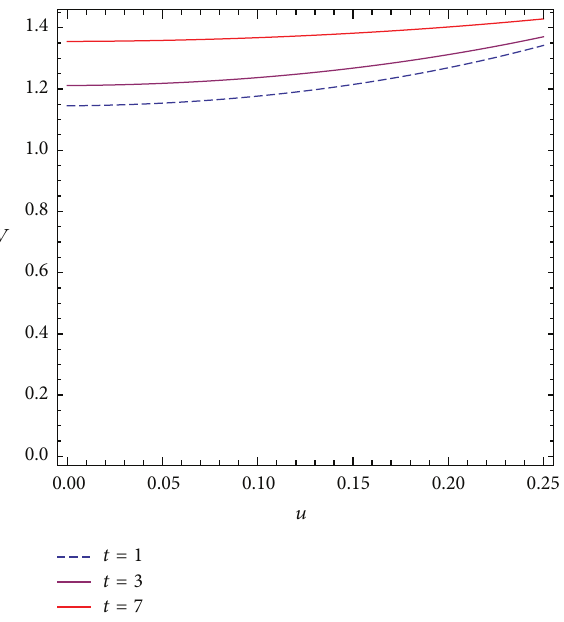
Figure 3: The optimal value function varies with respect to 𝑢 at low